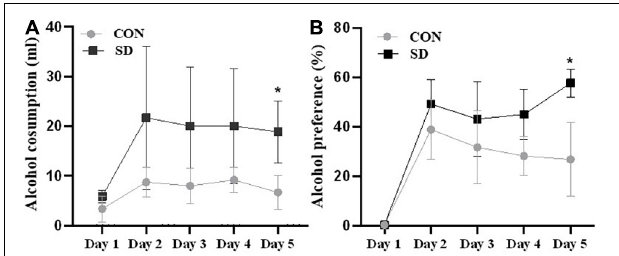
FIGURE 3 | Alcohol consumption. Alcohol consumption was assessed in rats using two-bottle choices, water versus 5% alcohol. The average volume of alcohol intake per day in milliliter (ml) (A) and the percentage of alcohol preference over water (B) were assessed for five consecutive days (PND39–PND43). Bars represent means ± SD. Data were analyzed using t -test, n = 6 rats per group. (*) Significantly different from control at p < 0.05. Group designations: control (CON), sleep deprivation